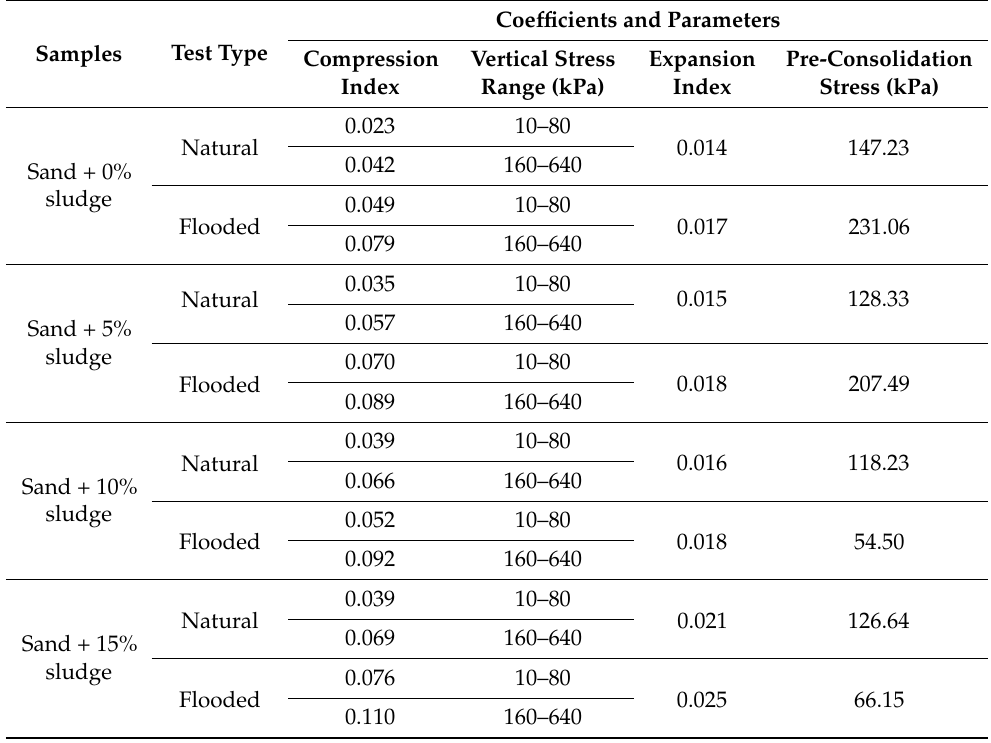
Table 6. Coefficients and parameters of the double oedometer tests with soil samples and soil–sludge mixtures with a dry specific weight of 17.0 kN/m 3